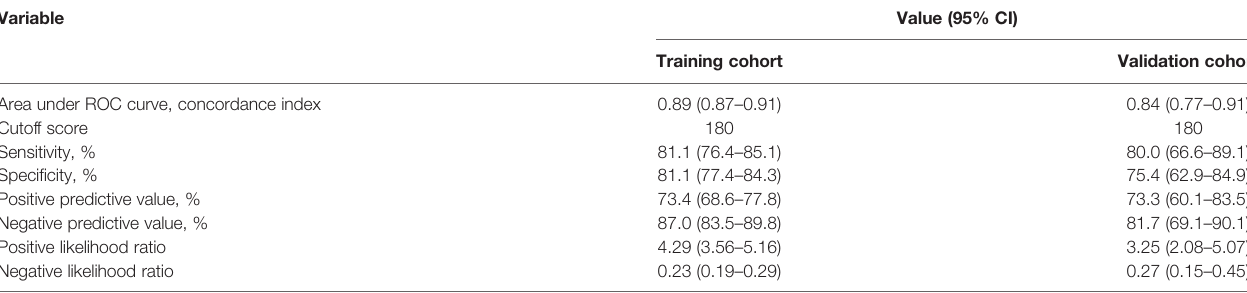
TABLE 4 | Accuracy of the prediction score of the nomogram for estimating the risk of DFU. Variable Value (95% CI) Training cohort Validation cohort Area under ROC curve, concordance